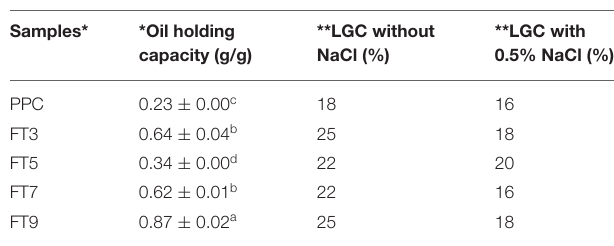
TABLE 4 | Oil holding capacity (g/g) and least gelation concentration (LGC) of pea protein aggregates isolated by membrane ultrafiltration after heat treatment (100 ◦ C) at different pH